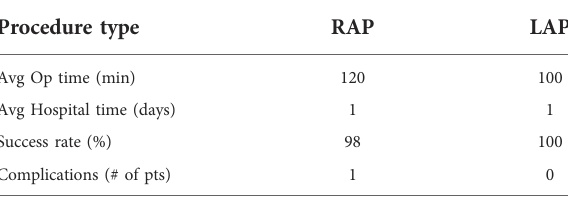
TABLE 3 Analysis.